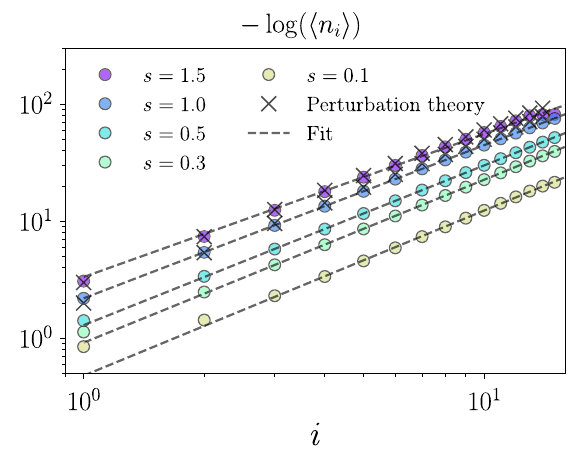
FIG. 3. Superexponential localization of the ground state. We plot the behavior of h n k i in double-log scale versus log scale. A fit of the form log h n k i ∝ k α (dashed lines) yields α ∼ 1 . 3 , indicating a superexponential decay. The result from a perturbation theory calculation at large s (crosses), without free parameters, shows good agreement with the numerical data.